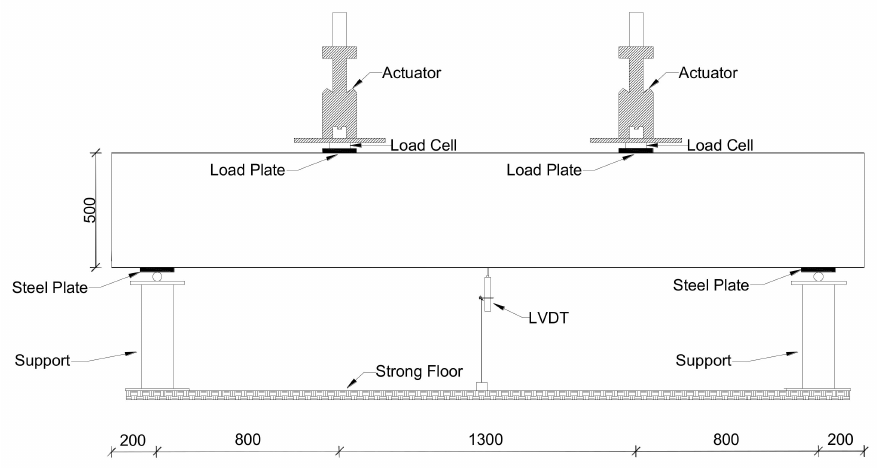
Figure 4. Test set-up (dimensions are in